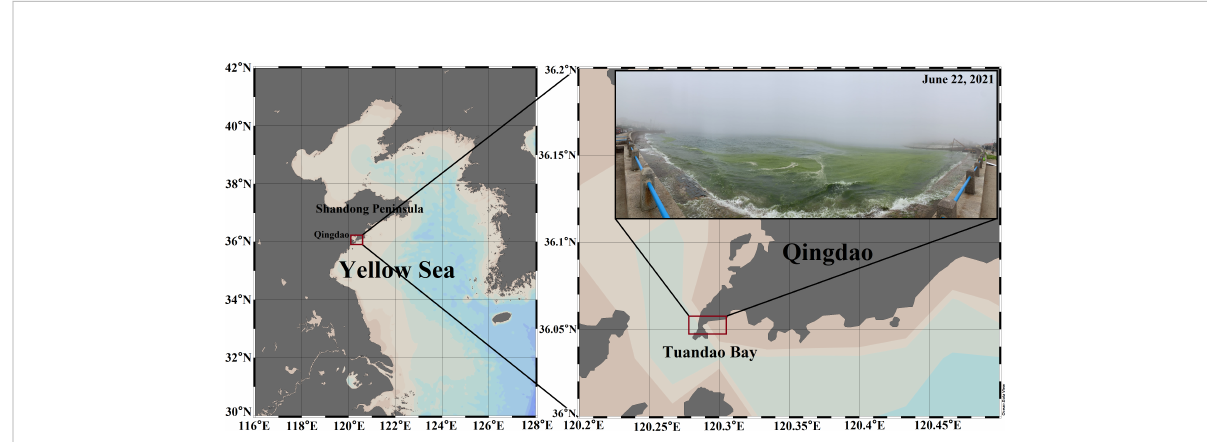
FIGURE 1 Locations of the investigation area in Tuandao Bay, Qingdao,